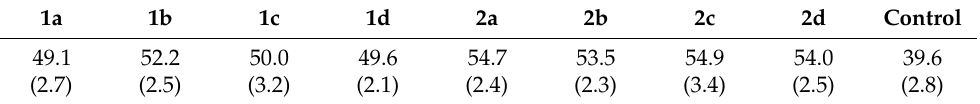
Table 2. The average contact angles θ (standard deviation) of 1a – d , 2a – d covalently linked to Au surface. Control is Au surface treated with peptide, without the CuAAC